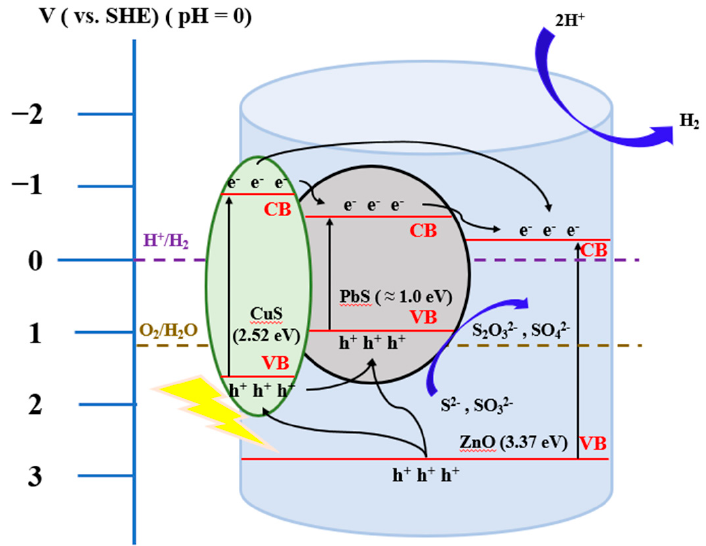
Figure 11. Bandgap correlation diagram of the prepared CuS/PbS/ZnO heterojunction photocata- lysts.